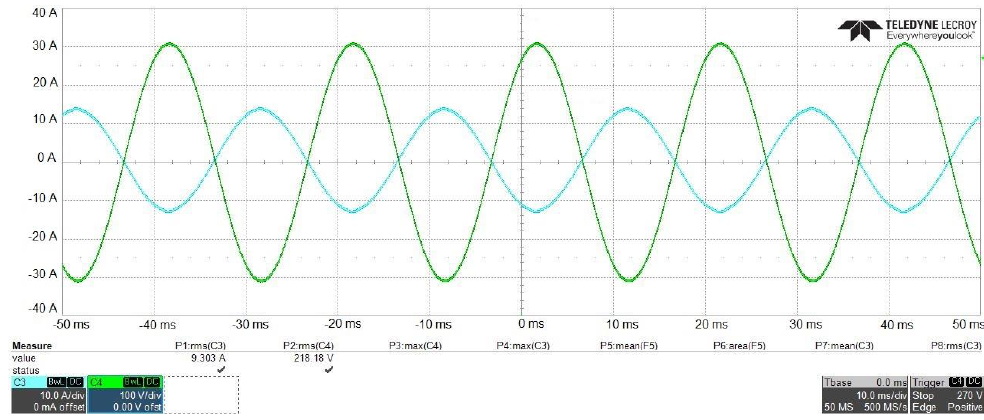
Figure 23. Mains voltage (C4, green) and current (C3, blue) at 26 kHz.